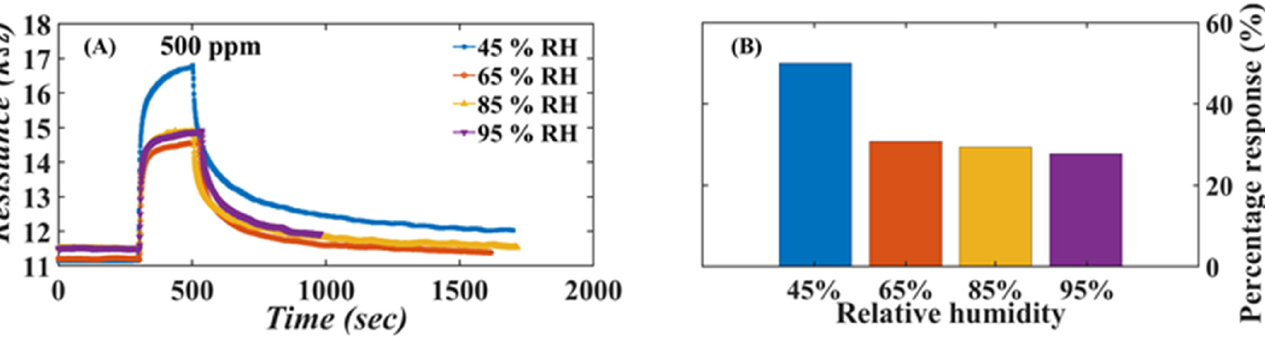
Figure 13. ( A ) Dynamic resistance of the sensor under different humidity conditions; ( B ) sensor response to 500 ppm ammonia under various relative humidity conditions.